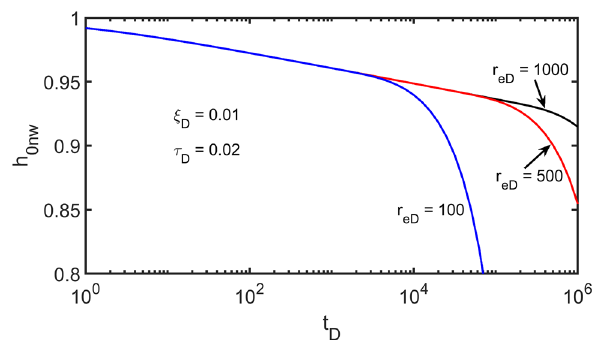
Fig. 7 Effect of no-flow boundary on normalized